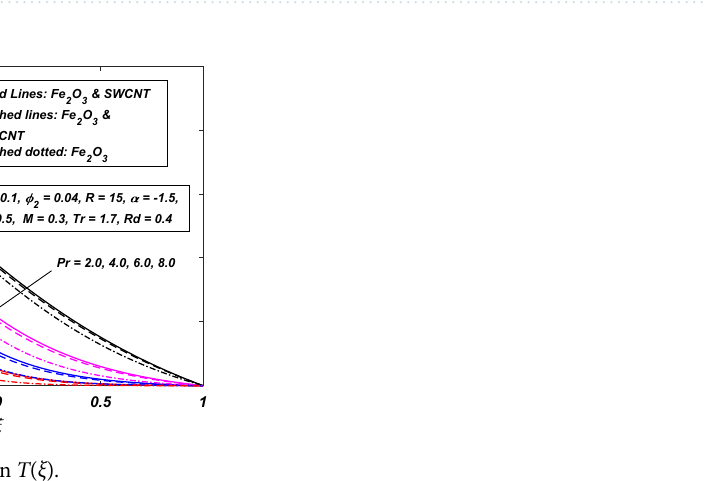
Figure 14. Influence of Tr on T ( ξ ).